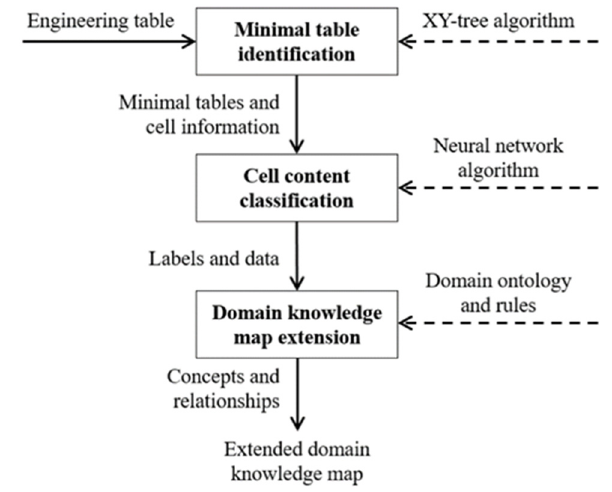
Figure 3. Overview of the proposed framework.